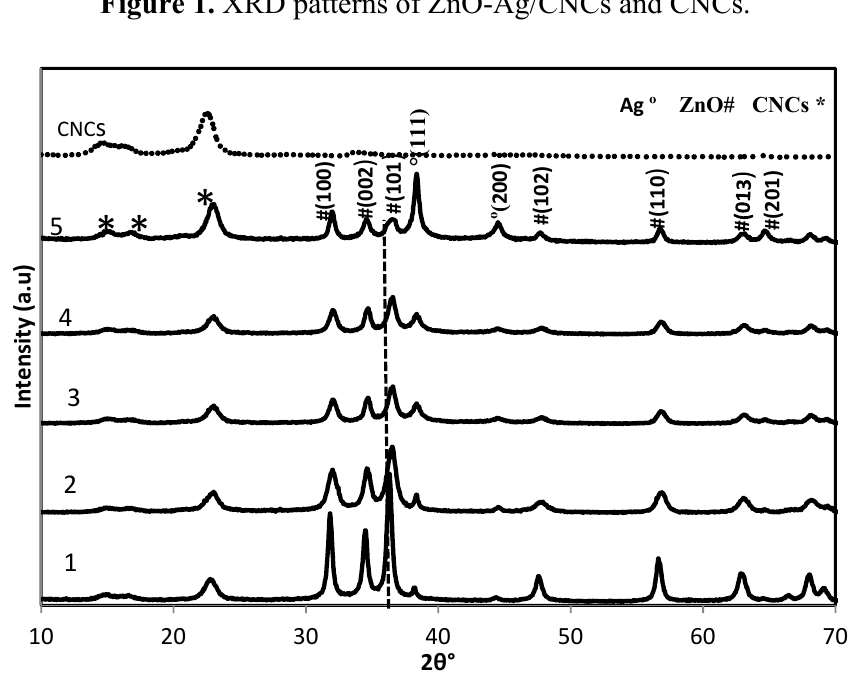
Figure 1. XRD patterns of ZnO-Ag/CNCs and